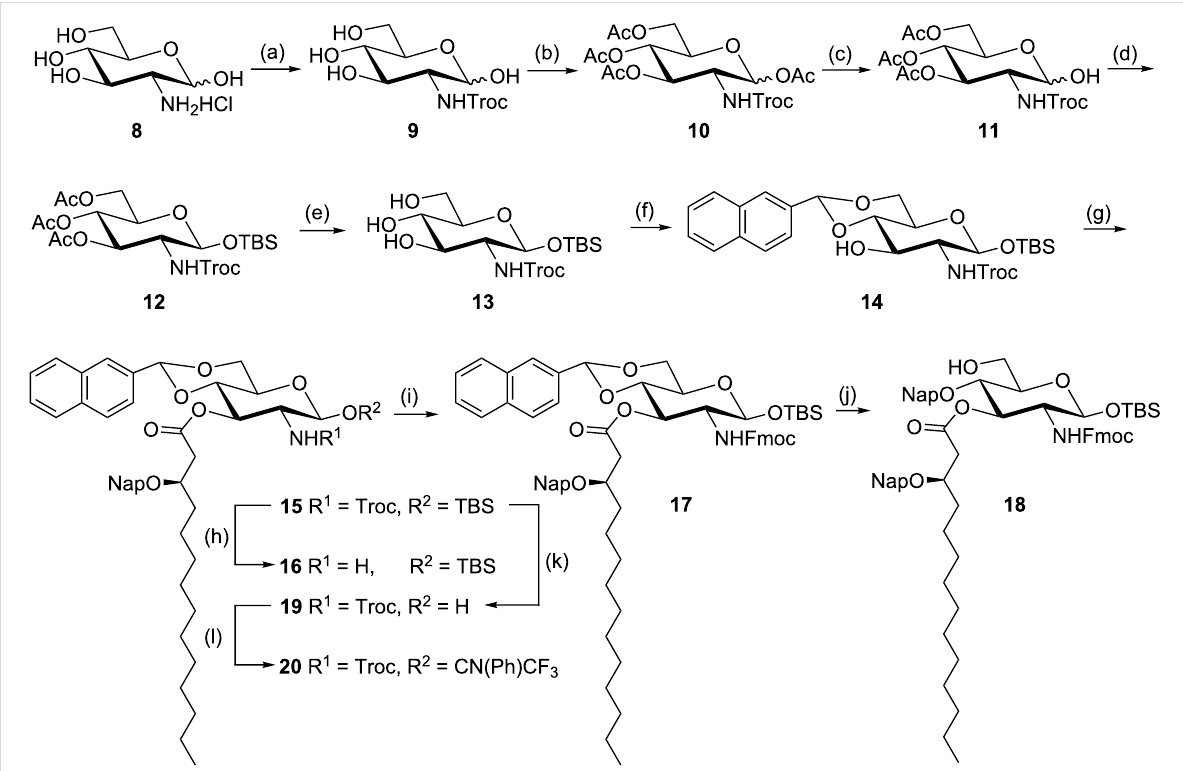
Scheme 2: Synthesis of monoacylated glucosamine building blocks. Conditions: (a) NaHCO 3 , TrocCl, H 2 O, 0 °C, 94% ; (b) Ac 2 O, pyridine, rt, 96%; (c) N 2 H 4 , AcOH, DMF, rt, 89%; (d) TBSCl, imidazole, DMF, rt, 93%; (e) guanidine hydrochloride buffer, rt; (f) NapC(OMe) 2 , camphorsulfonic acid,